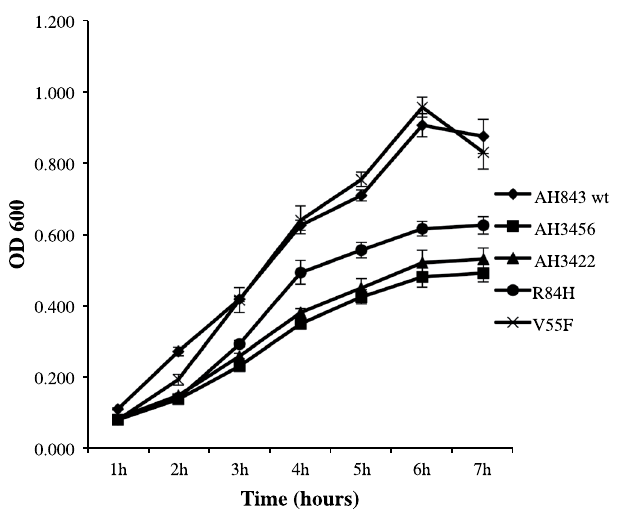
Figure 5. Autolysis assay for HMPC-resistant mutants containing Val55Phe and Arg84His mutations in MgrA. Bacteria were grown in a 96-well plate at 37 °C without shaking and optical density at 600 nm (OD 600 ) was measured hourly. The strains AH843, AH3456, and AH3422 were included as controls. The experiment was repeated twice with triplicates for each strain. Data show the mean + / − standard deviation, and p < 0.001 by one-way RM ANOVA 5 followed by Student-Newman-Keuls